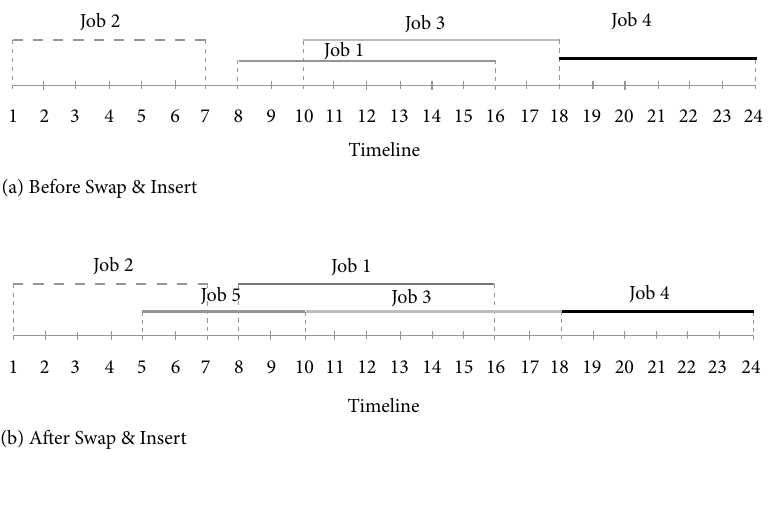
Fig. 6. Example for demonstrating the execution of the Swap & Insert algorithm